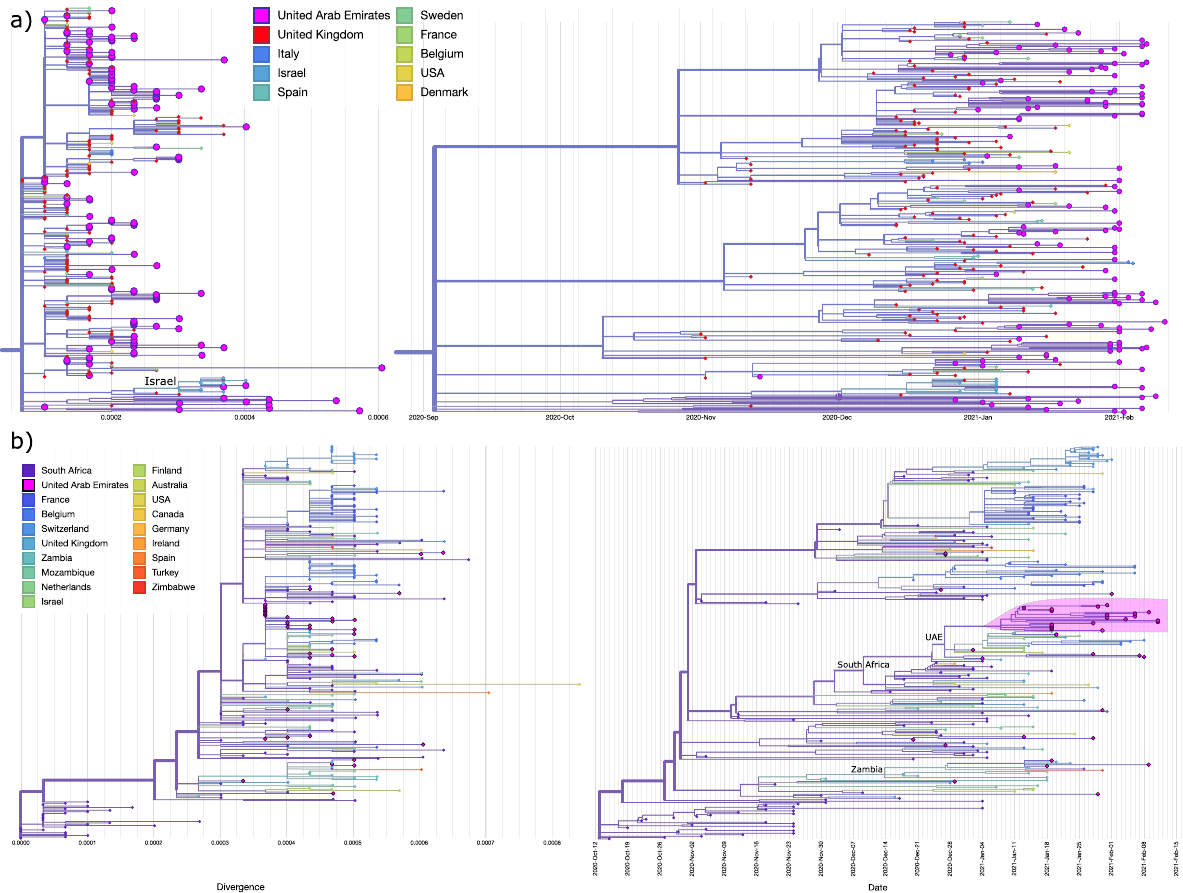
Figure 2. Divergence and time trees for VOCs. ( a ) B.1.1.7/Alpha ( b ) B.1.351/Beta, local cluster highlighted. UAE sequences are contextualized with most similar international sequences as per BLAST search. In both cases, high phylogenetic diversity indicates multiple